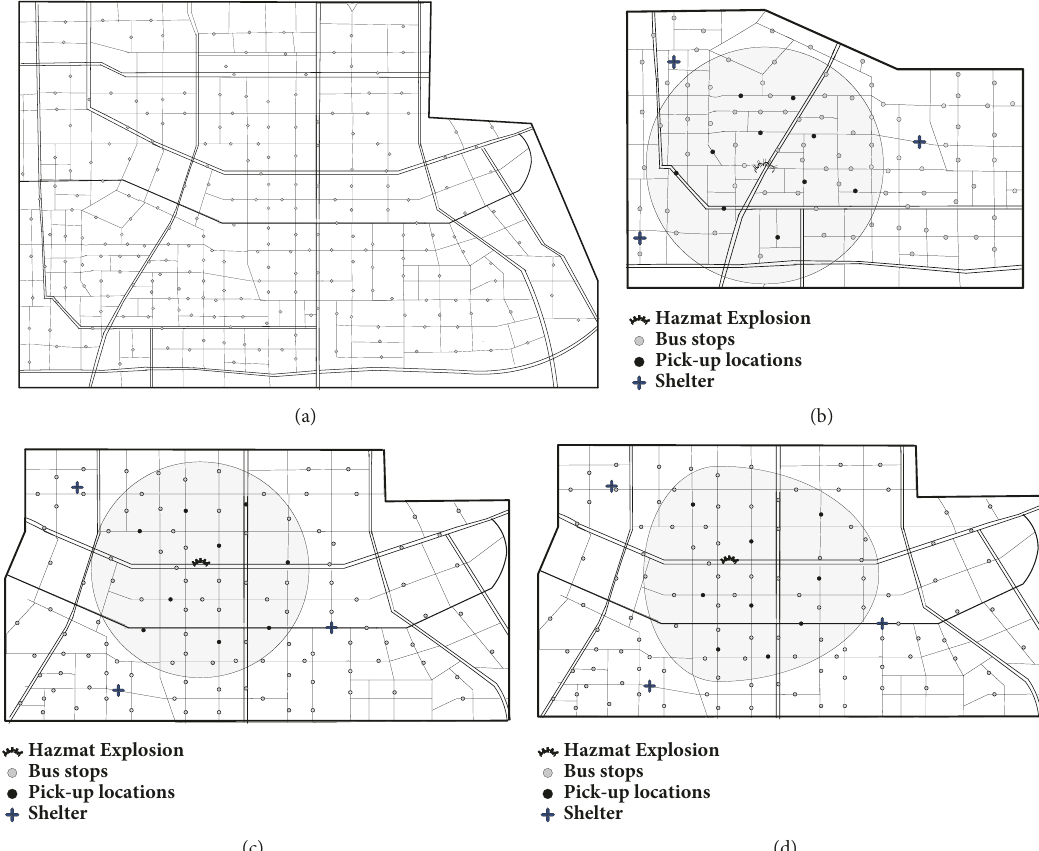
Figure 3: Illustration of network and evacuation scenarios: (a) network of southern part of Xi’an; (b) Scenario A; (c) Scenario B; (d) Scenario